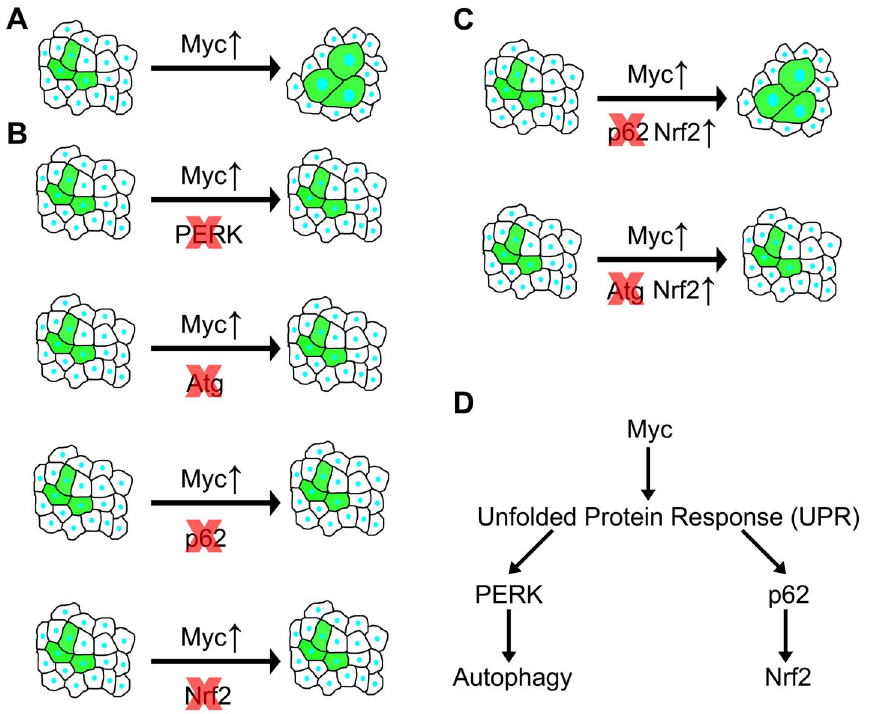
Figure 7. Summary of genetic interactions in the context of Myc-induced overgrowth. (A) Overexpression of Myc in GFP-positive cells leads to a cell-autonomous increase of size. (B) Genetic inhibition of PERK signaling, autophagy, p62 or Nrf2/cnc signaling prevents Myc-induced overgrowth, as GFP-positive cells are now unable to overgrow neighboring cells. (C) Overexpression of Nrf2 restores Myc-induced overgrowth in the absence of p62, while it has no effect in autophagy-deficient cells, indicating that Nrf2 acts downstream of p62 but in parallel to autophagy. (D) Overexpression of Myc induces UPR, leading to activation of PERK in the ER that triggers autophagy. At the same time, cytoplasmic UPR presumably results in accumulation of p62, which then activates